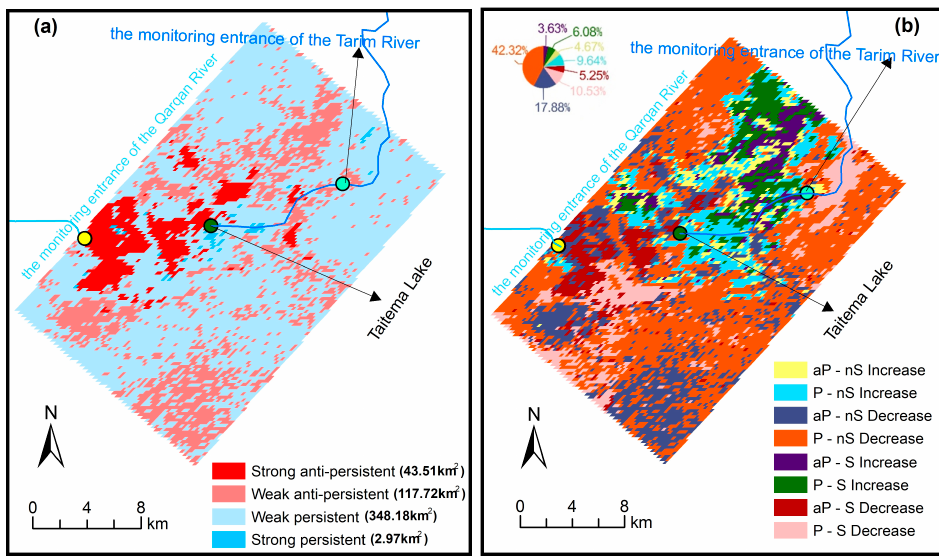
Figure 7. Hurst exponent of the fractional vegetation cover ( a ) and future trends ( b ) in Taitema lake region (ap: anti-persistent; p: persistent; S: Significantly; nS: